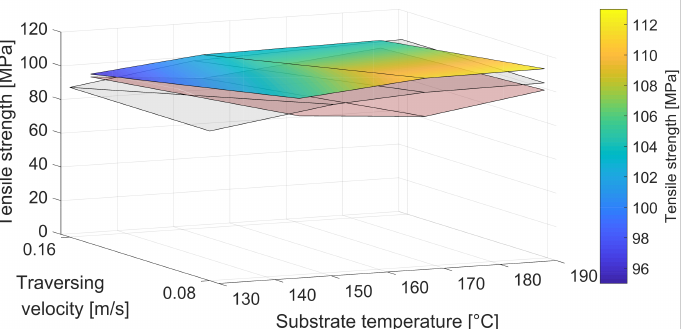
Figure 3. Tensile strength of the heated specimens in the longitudinal direction with the reference tensile strength for unheated specimens at the same base temperature (red) and the achieved heated temperature (gray).